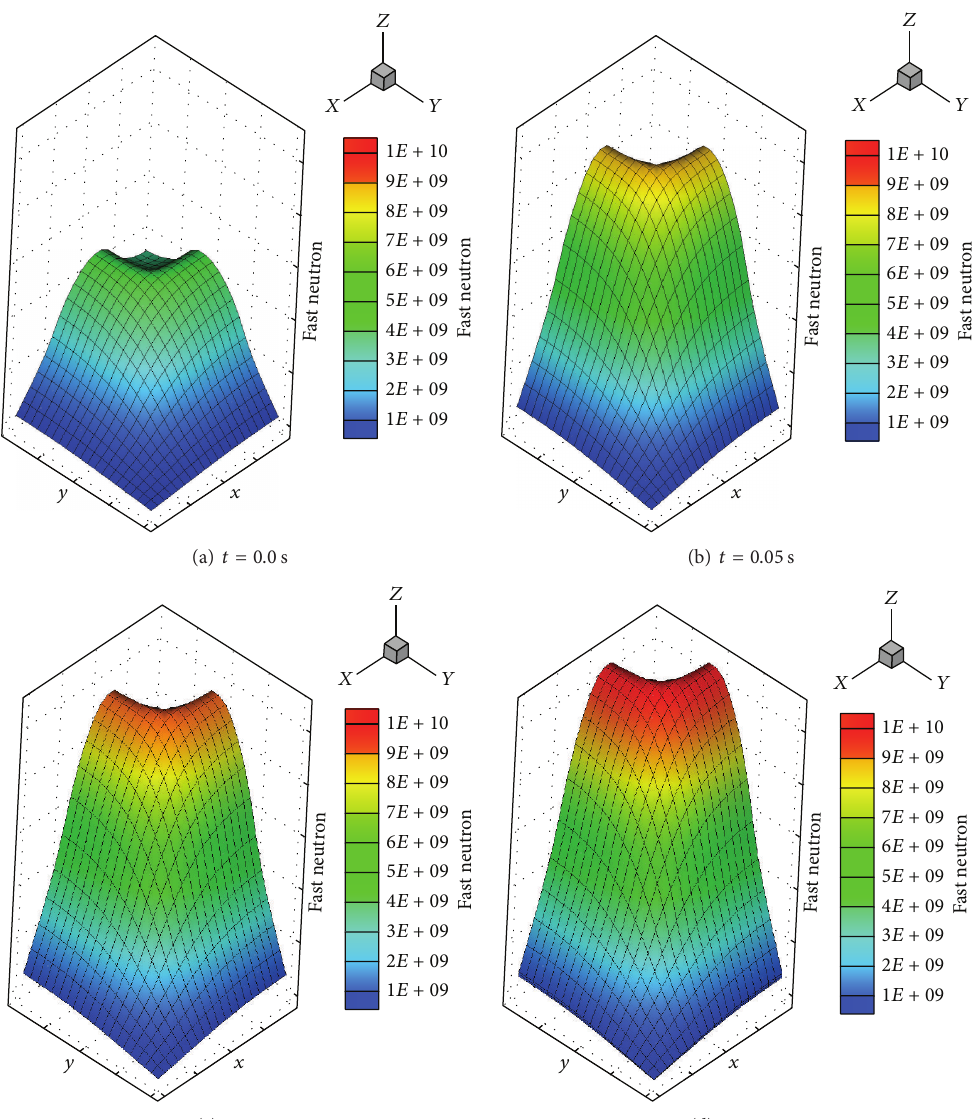
Figure 6: Fast neutron flux distribution versus time in TWIGL problem during step